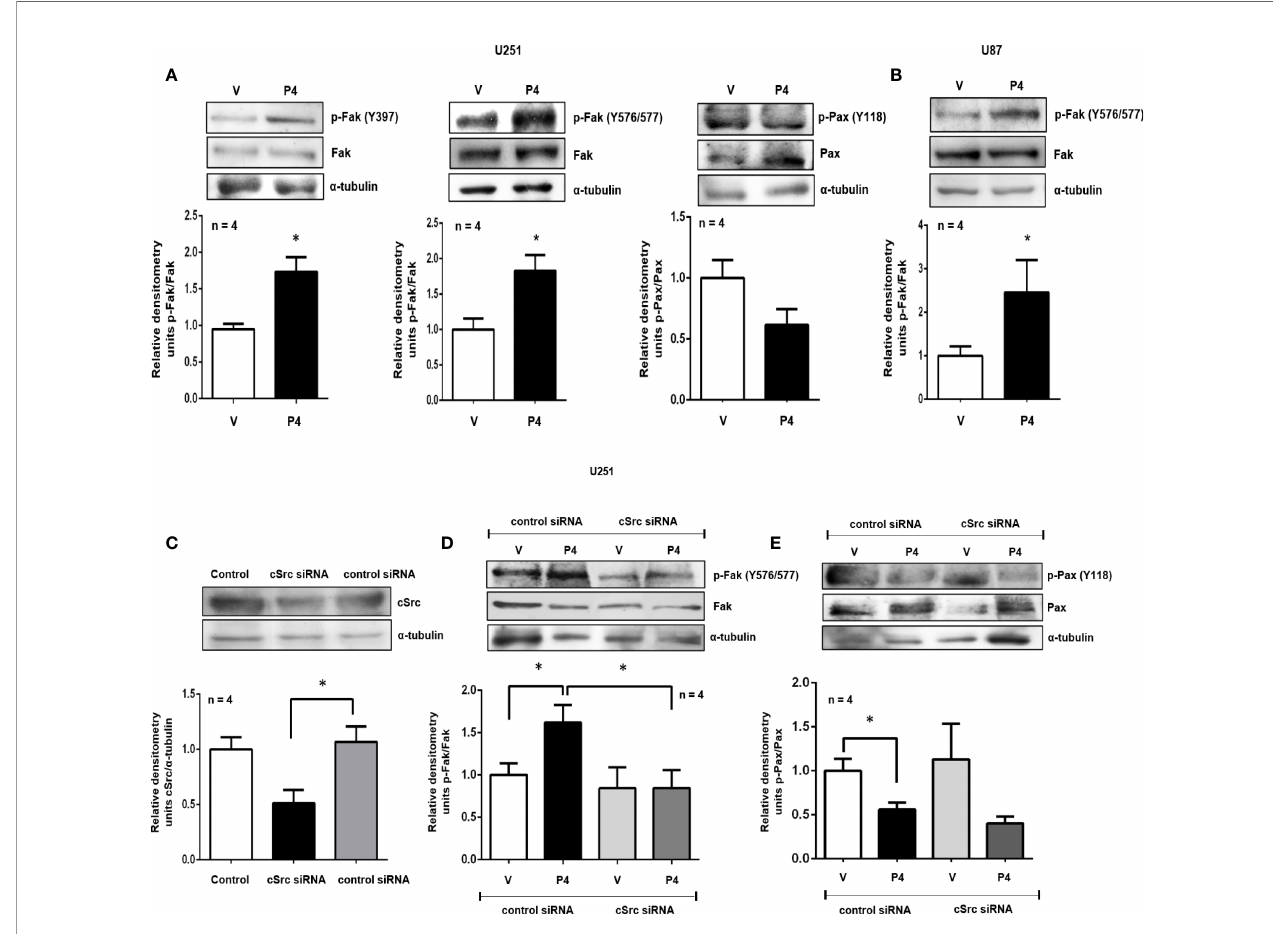
FIGURE 2 | P4 induces the activation of Fak and Pax through cSrc in glioblastoma cells. (A, B) U251 and U87 cells were treated with P4 (50 nM) or vehicle (V, DMSO 0.01%) for 20 min. (C) U251 cells were transfected with cSrc siRNA and a control siRNA (an aleatory RNA sequence) (100 nM) or were only treated with lipofectamine (Control). (D, E) Transfected cells with cSrc siRNA or control siRNA were treated with P4 (50 nM) or vehicle (V, DMSO 0.01%) for 20 min. Upper panels show the representative western blots for, cSrc, p-Fak, Fak, p-Pax, Pax, and a -tubulin. Lower panels show the densitometric analysis. Data were normalized respect to the vehicle or control. Results are expressed as the mean ± S.E.M. n = 4; *p <